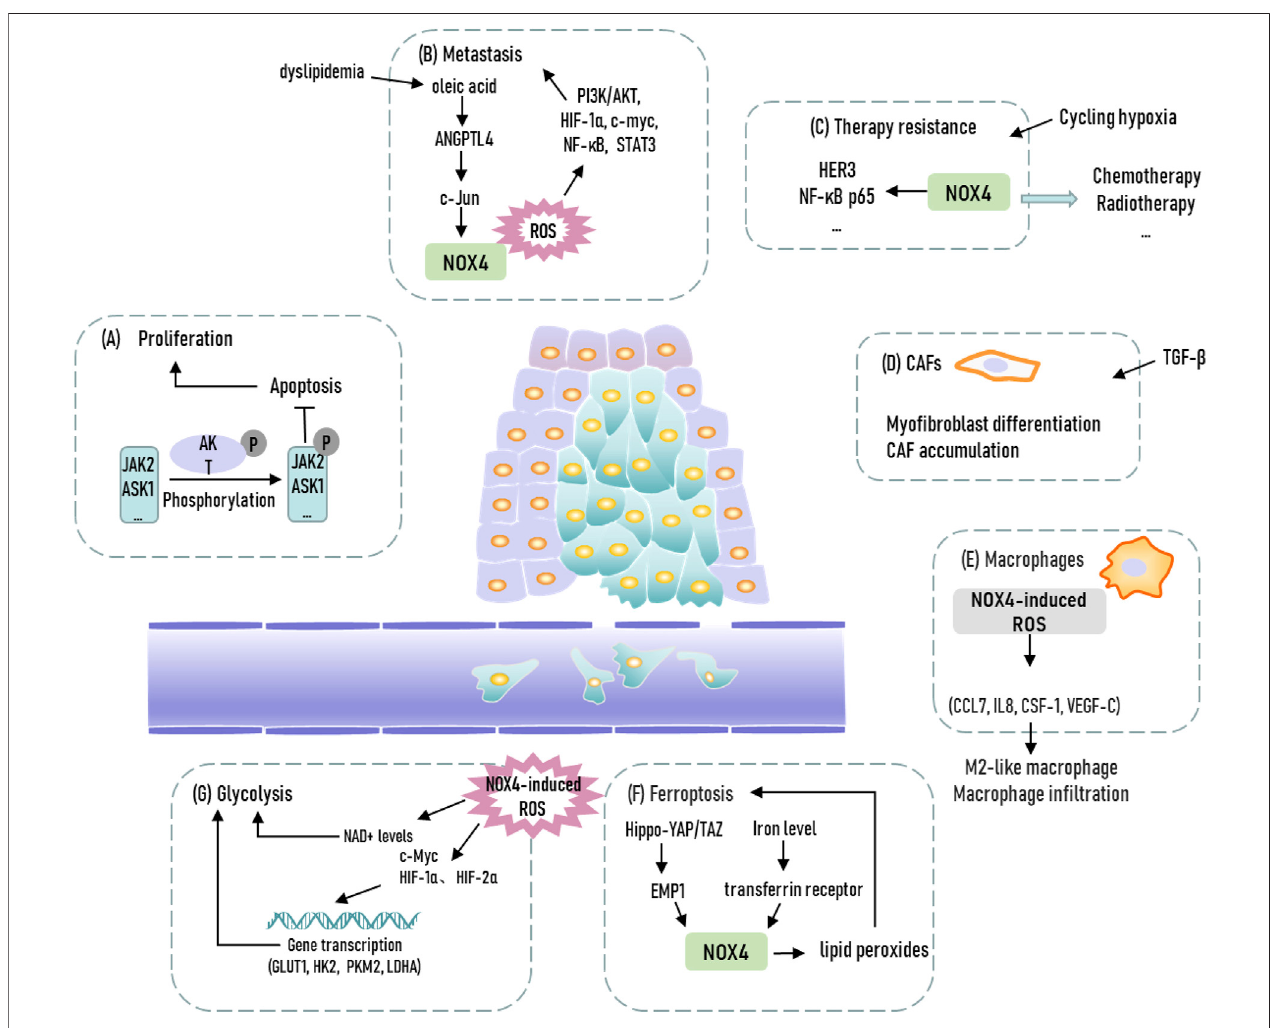
FIGURE1 | Representation of biological functions ofNOX4 incancer. JAK2, Janus kinase 2; ASK1, apoptosis signal-regulating kinase 1; ANGPTL4, Angiopoetin- like4;CAFs, cancer-associated fi broblasts; EMP1,epithelialmembraneprotein 1;GLUT1,glucose transporter 1;HK2,hexokinase2;PKM2, pyruvatekinase isoform2; LDHA, lactate dehydrogenase